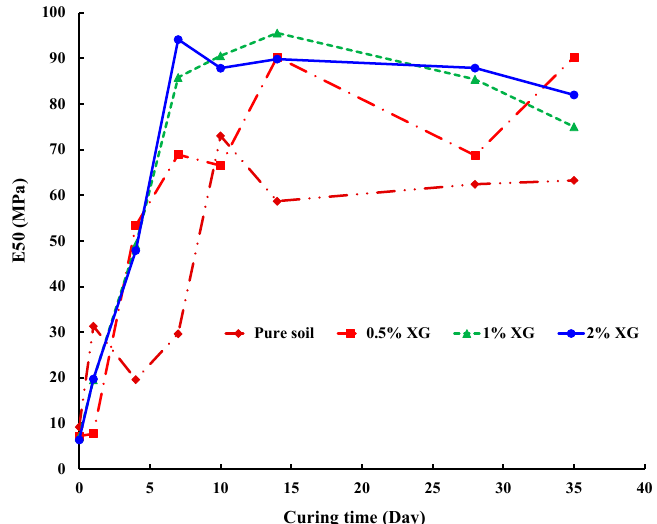
Figure 3. Relationship between the secant stiffness and curing time for the different content of XG.